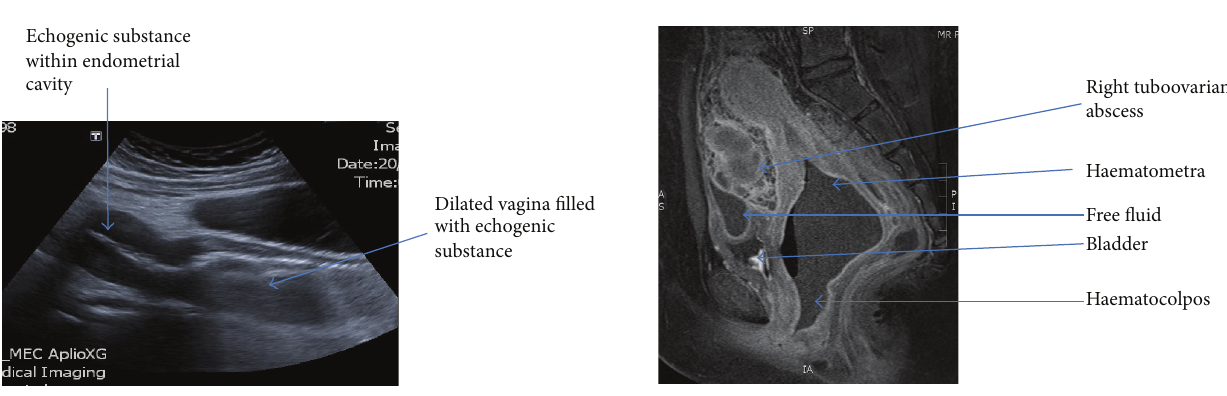
Figure 1: Transabdominal ultrasound of uterus and vagina.